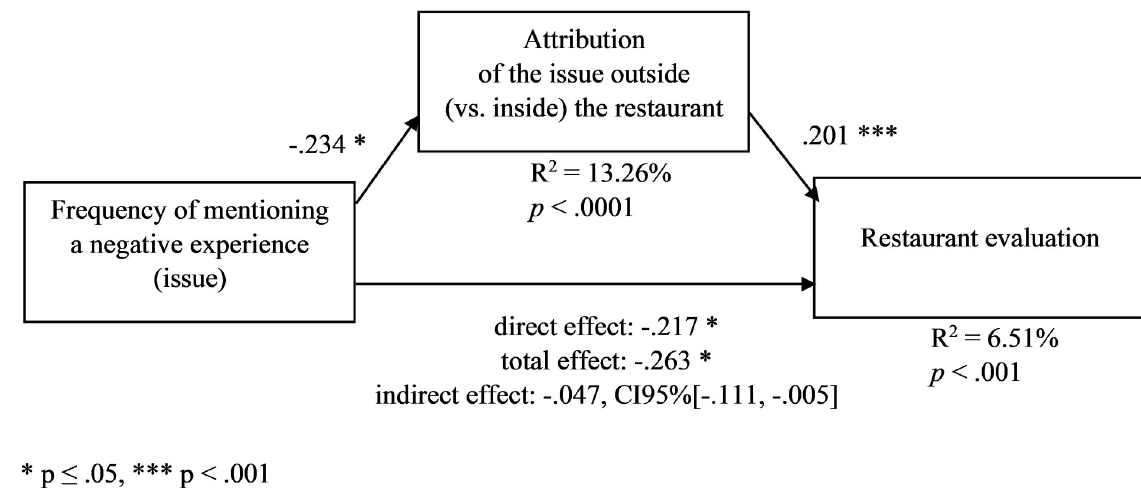
Fig 5. Frequency of mentioning a negative experience (issue) (manipulated), the attribution of the issue outside (vs. inside) the restaurant, and the restaurant evaluation–a mediation model (Study 2). The other manipulated variables are included as covariates. � p � .05, ��� p < .001.